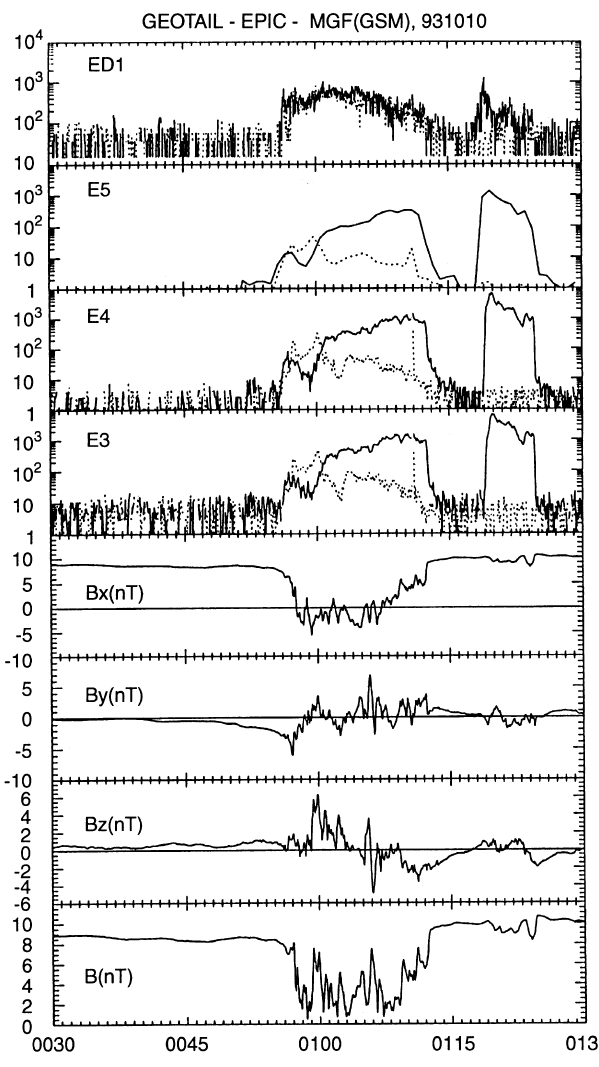
Fig. 2. The time plot of the magnetic field and energetic particle conditions for October 10, 1993 between 0030 UT and 0130 UT are presented. The top four panels show the di(cid:128)erential energy fluxes of the energetic particle channels ED1, E5, E4, and E3. The bottom four panels show the magnetic field in GSM co-ordinates at 3 s resolution. For each channel the tailward ( solid line ) and earthward flux ( dotted line )